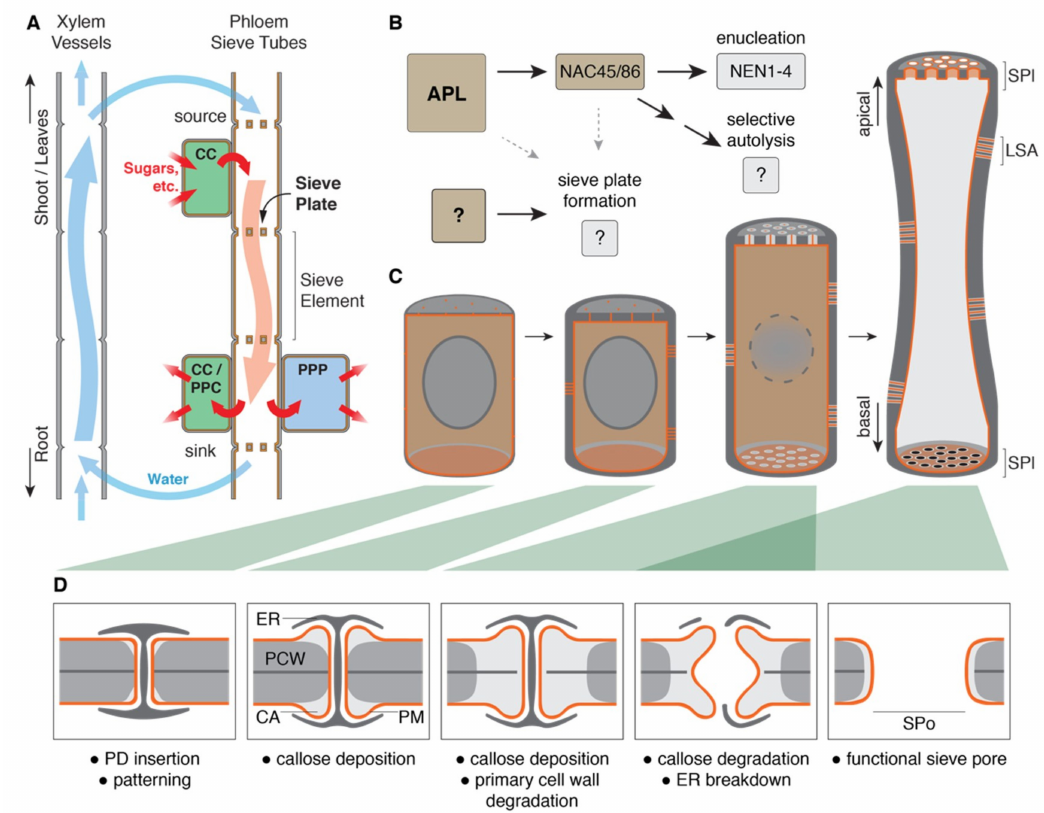
Figure 1. Sieve element differentiation and formation of the terminal sieve pores. ( A ) A schematic overview of the plant vascular system: Water and nutrients are transported from root to shoot and leaves through the xylem. In source leaves, loading of sugars from companion cells into the sieve elements increases the osmotic potential and generates pressure to push phloem sap towards sink tissues. There, sugars are unloaded through companion cells and possibly phloem parenchyma cells [12] or in the root through the phloem pole pericycle for further transport into adjacent cells [13]. ( B ) ALTERED PHLOEM DEVELOPMENT (APL) initiates sieve element differentiation through downstream transcription factors and enzymes which then control cellular remodeling processes like enucleation and selective autolysis. Sieve plate formation is influenced by APL and NAC DOMAIN CONTAINING PROTEIN (NAC) 45/86 but occurs also in the absence of these transcription factors. ( C ) The differentiation of an idealized sieve element: Cells are initially indistinguishable from their neighbors, yet the pattern of the future pores is already determined by apical and basal plasmodesmata. During further differentiation, callose is deposited around terminal plasmodesmata and lateral sieve areas are formed, while nuclear breakdown and cytoplasmic clearing begin. Once selective autolysis is completed, residual organelles (not shown) remain tethered to the lateral plasma membrane. Sieve pores are opened, and sieve elements stretch with the growing surrounding tissues. ( D ) The progression of the sieve pore formation: A plasmodesma with the protruding ER desmotubule is gradually transformed. Callose is deposited as cones around the plasmodesma, creating a callose plug, while cellulose of the primary cell wall is simultaneously degraded. Just until pore opening, callose maintains the cell wall integrity. Pore opening begins from the center of the structure and degrades the callose plug, including the remaining middle lamella, while autolysis removes the desmotubule. The size of the final pore is determined by the original extent of the callose plug. CC : companion cell; PPC : phloem parenchyma cells; PPP : phloem pole pericycle; SPl : sieve plate; LSA : lateral sieve area; PD : plasmodesma; ER : ER desmotubule; PCW : primary cell wall with middle lamella; CA : callose; PM : plasma membrane; and SPo : sieve